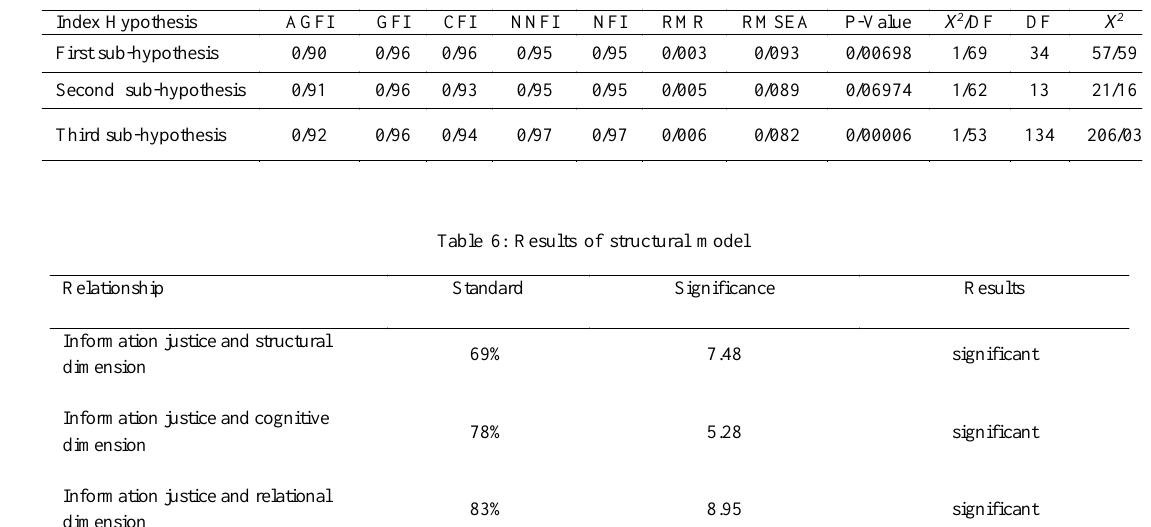
Table 5: Results of sub hypotheses